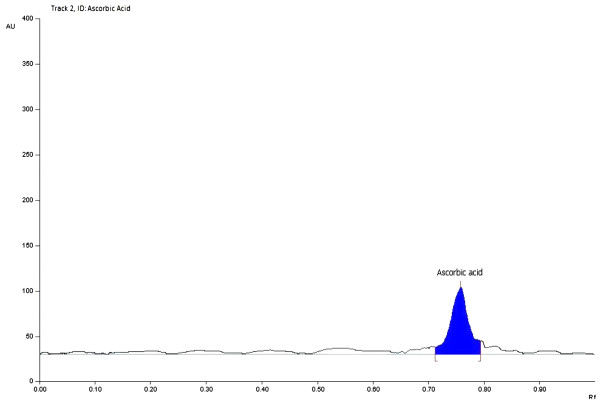
High performance thin liquid chromatography profiles of standard Ascorbic acid.